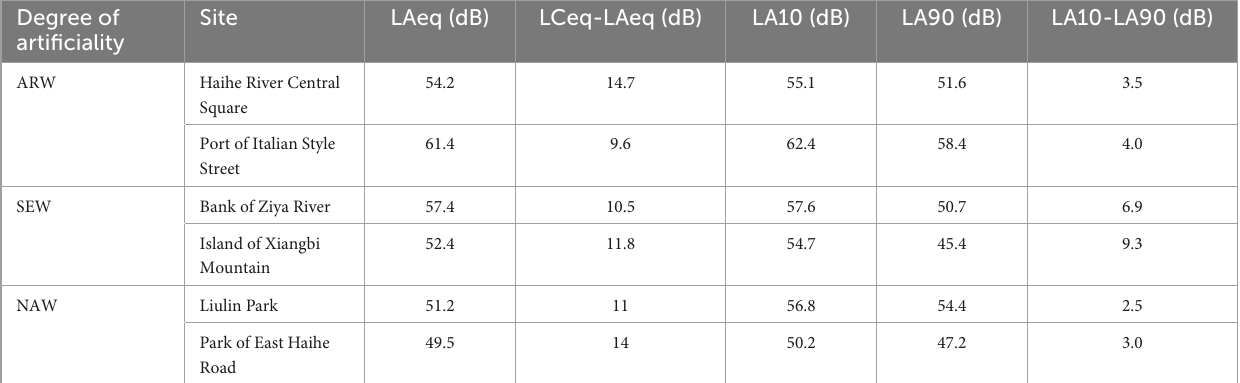
TABLE 1 Acoustical properties of six waterfront spaces selected in field